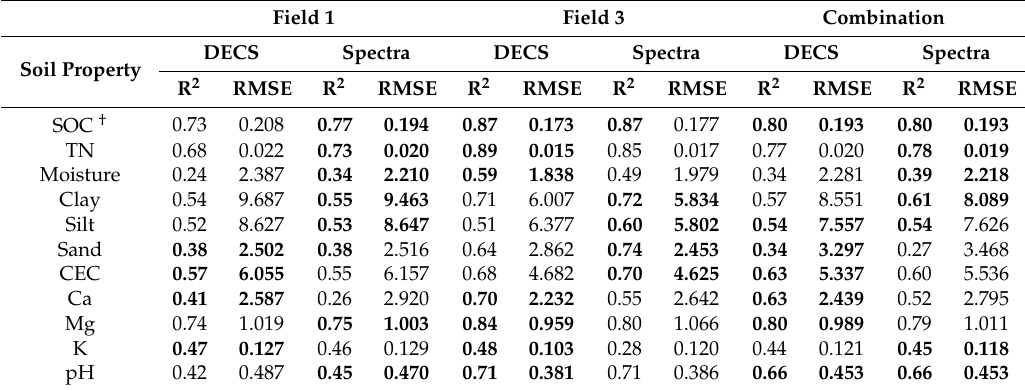
Table 5. Prediction R 2 and root mean square error (RMSE) calculated with different field data using the combination of depth, EC a , CI and spectra (DECS) and spectra alone. See Table 1 for units of RMSE. For each soil property within each field or the combination of both fields, bold text highlights the best R 2 and